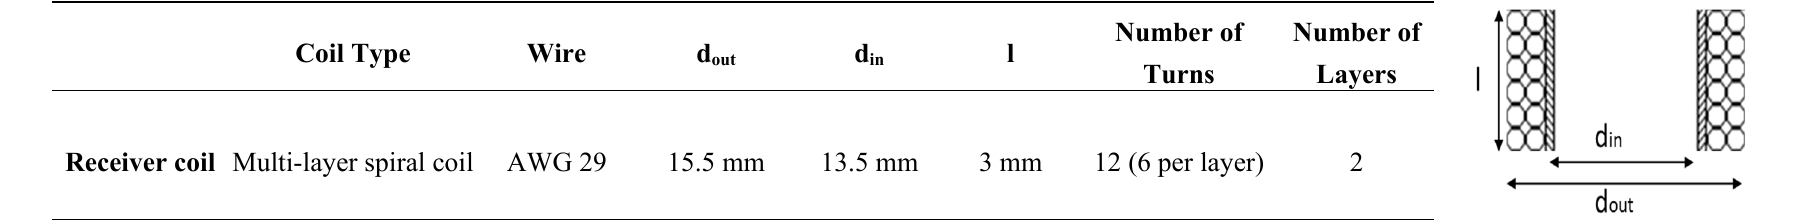
Table 2. Receiver coil